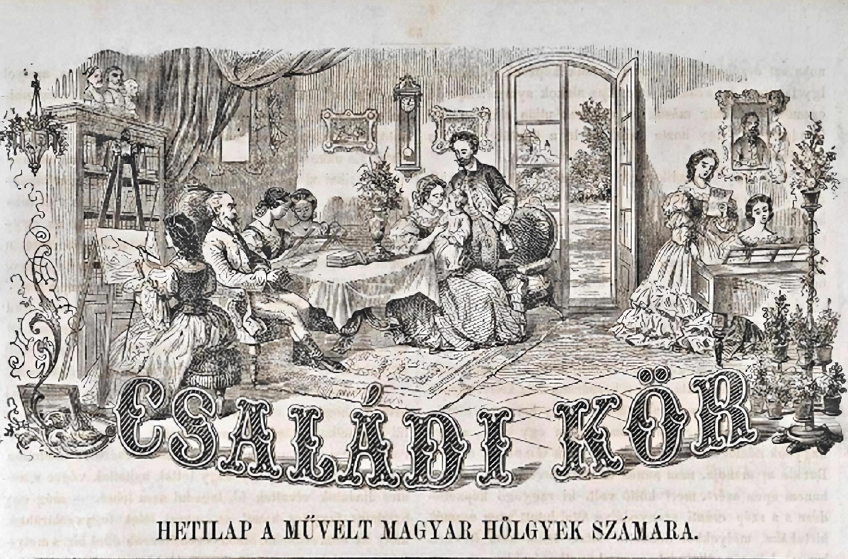
Fig. 2 The masthead of Családi Kör picturing women engaging in different activities, such as painting, music, and